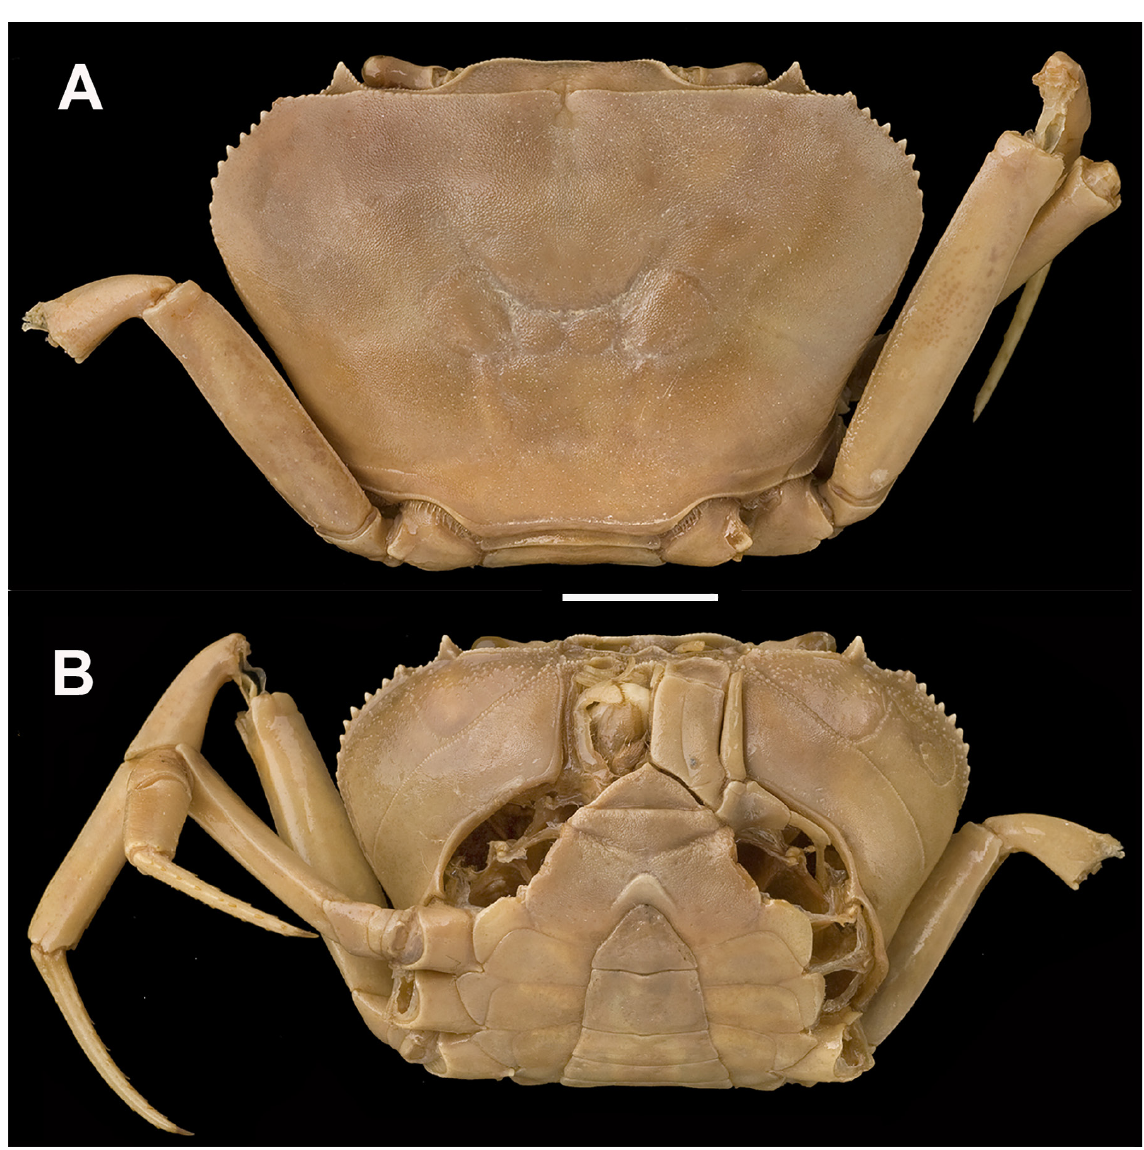
Fig. 10. Potamonautes orbitospinus (Cunnington, 1907), lectotype, adult, ♂, from Nkhata Bay, Lake Malawi, Malawi, CW 56.9 mm (NHMUK 1908.1.31.27). A . Entire animal, dorsal view. B . Entire animal, ventral view. Scale bar = 11.9 mm. Photographs by Phillip Crabb,